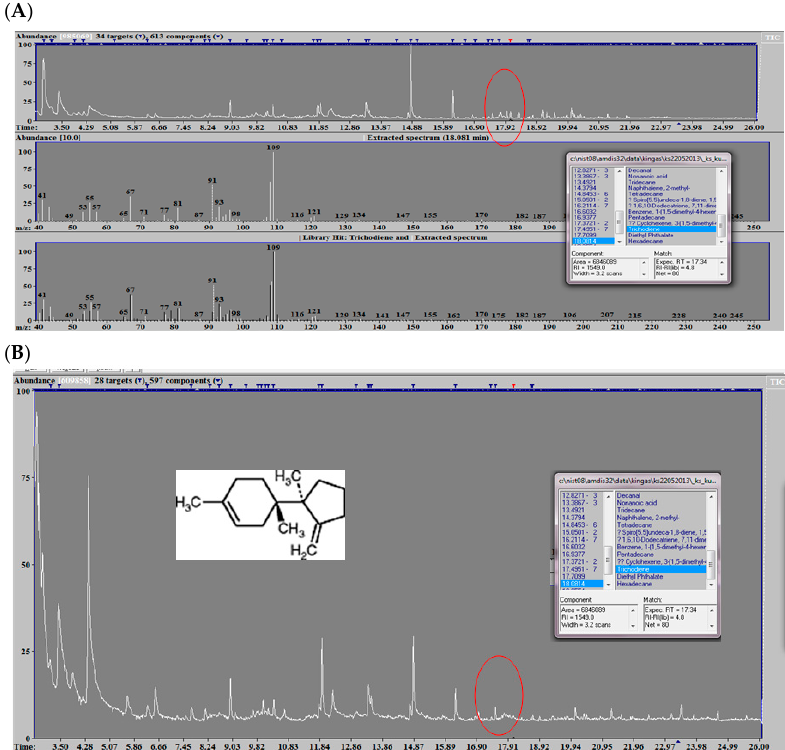
Figure 2. Examples of VOC chromatograms with particular emphasis on trichodiene (the circle marks the area on the chromatogram that allows for the interpretation of the analyzes) ( A ) commercial farming (chromatogram, mass spectrum) and ( B ) backyard farm breeding (chromatogram, structural formula).